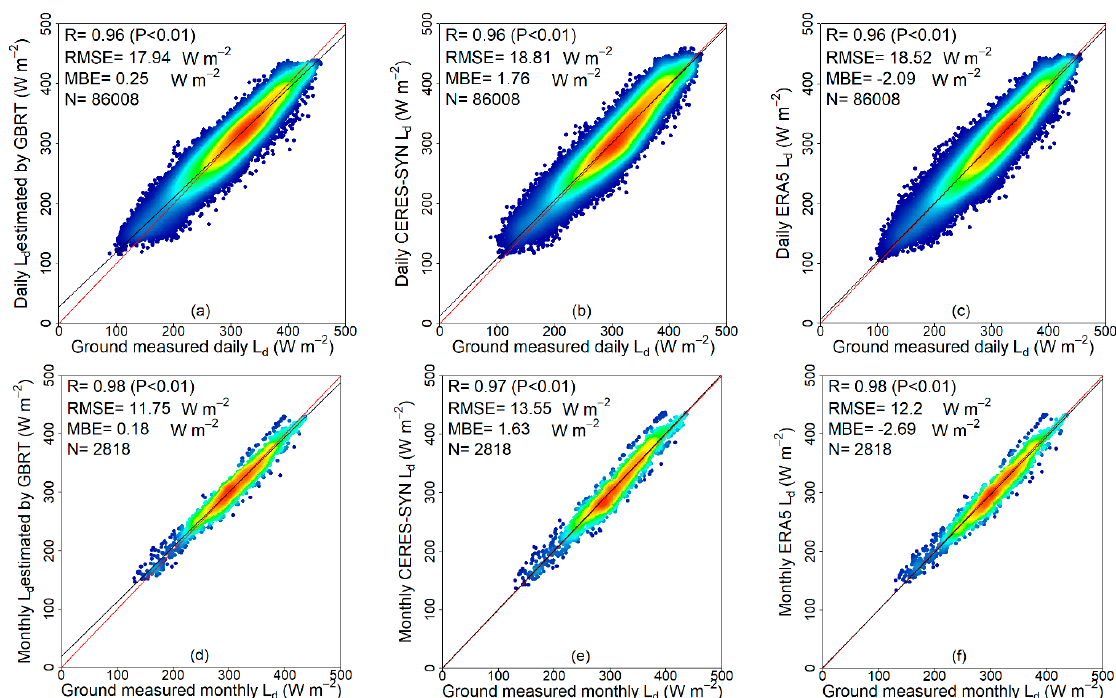
Figure 6. Evaluation results of the daily and monthly ( a , d ) L d estimates based on the GBRT model, ( b , e ) CERES-SYN L d product, and ( c , f ) ERA5 L d retrieval with a 100-km resolution against the ground measurements from March 2000 to December 2018.